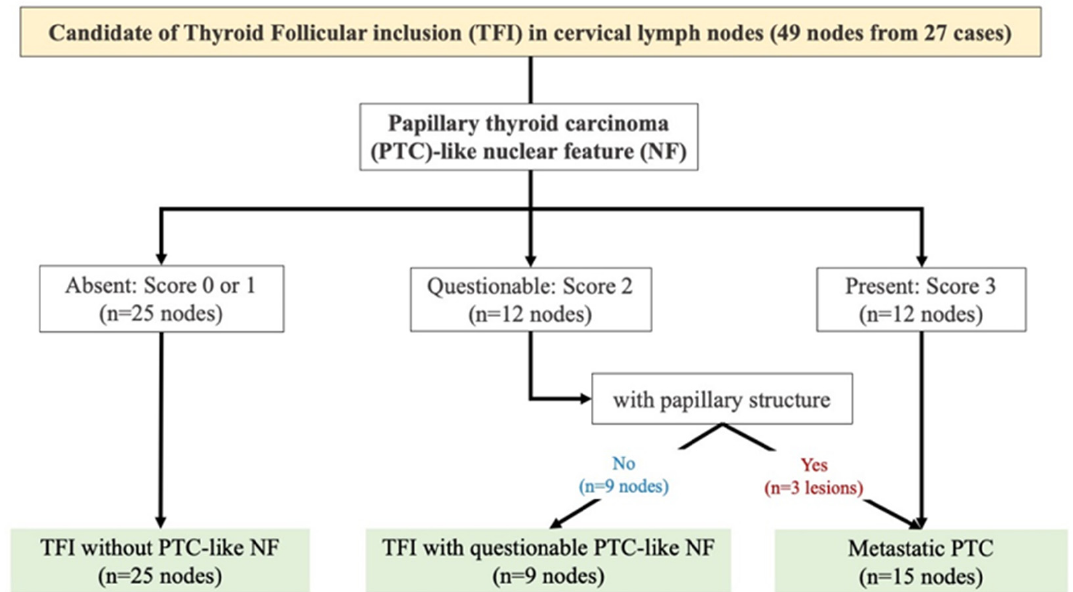
Figure 4. The number of thyroid follicular inclusions (TFIs) in cervical lymph nodes.